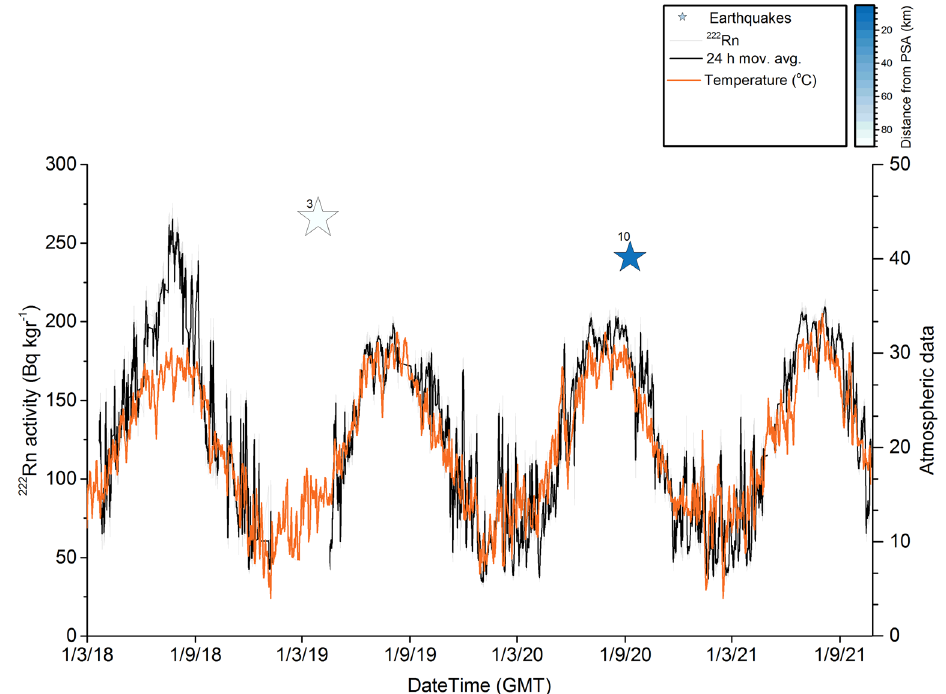
Figure 7. The level of the soil radon concentration at the Psatha station systematically follows the atmospheric temperature. From the overall picture of the monitoring, a substantial drop on the radon lever can be observed in the second period of the recording, after the Mw5.6 event of Mar. 30, 2019 (event No.3 in Fig. 4a). The identification of the radon anomalies is very difficult even for the closest events (event No.10 in Fig.